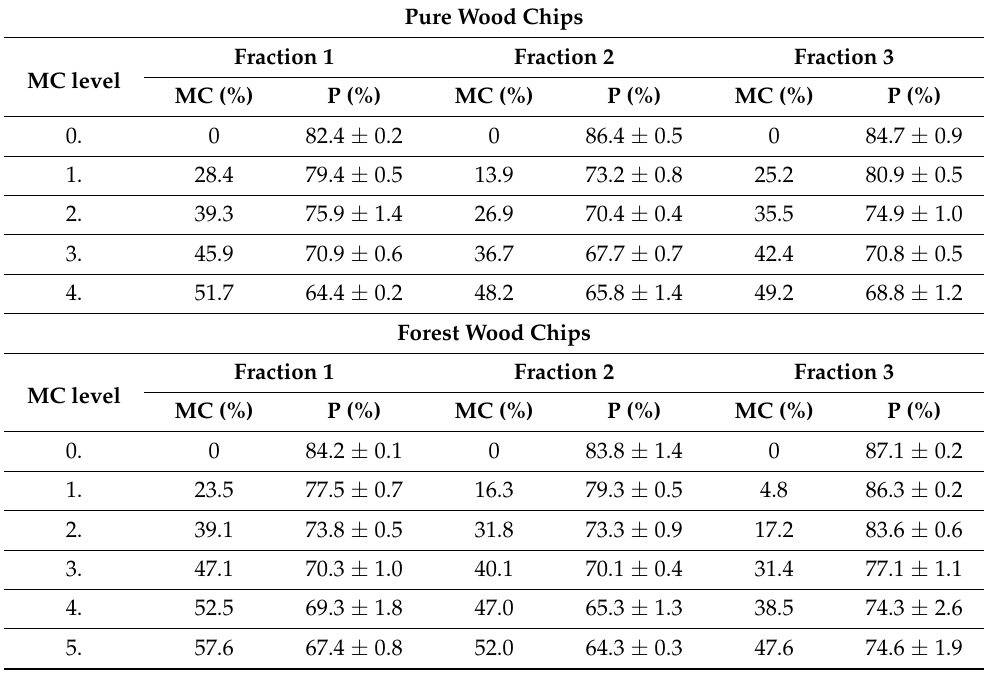
Table 1. Moisture content (MC) and porosity (P) of pure and forest wood